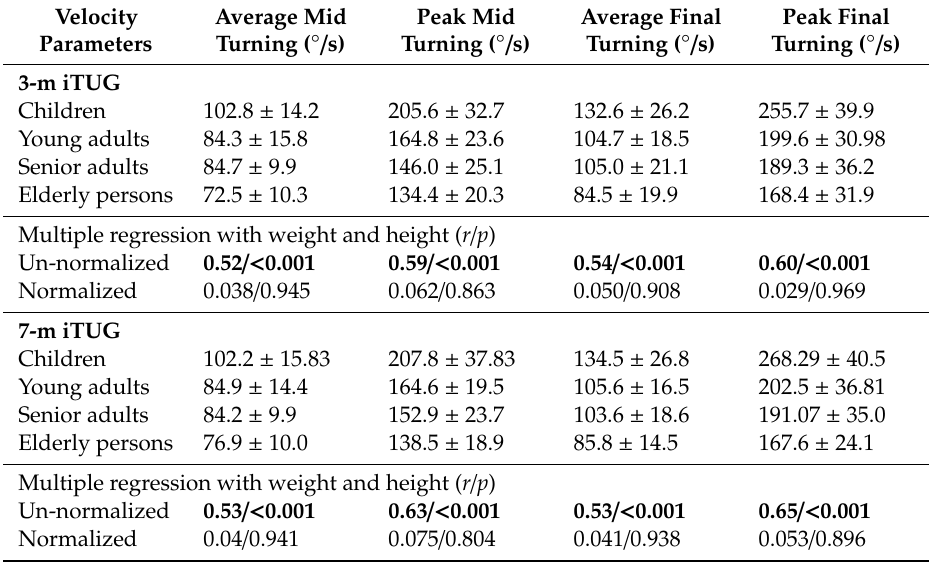
Table 3. Original un-normalized velocity